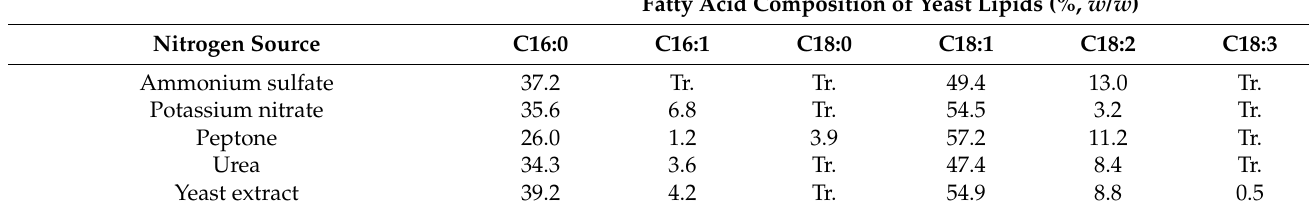
Table 5. Fatty acid composition of the cellular lipids produced by Cryptococcus curvatus ATCC 20509, when cultivated on crude glycerol in shake-flask experiments (Glyc0 ≈ 50 g/L), when various nitrogen sources were used. Time of fermentation for the determination of the fatty acid composition was between 170 and 220 h after inoculation. Culture conditions as in Table 2. Tr.: traces (<0.5%). Fatty Acid Composition of Yeast Lipids (%, w/w